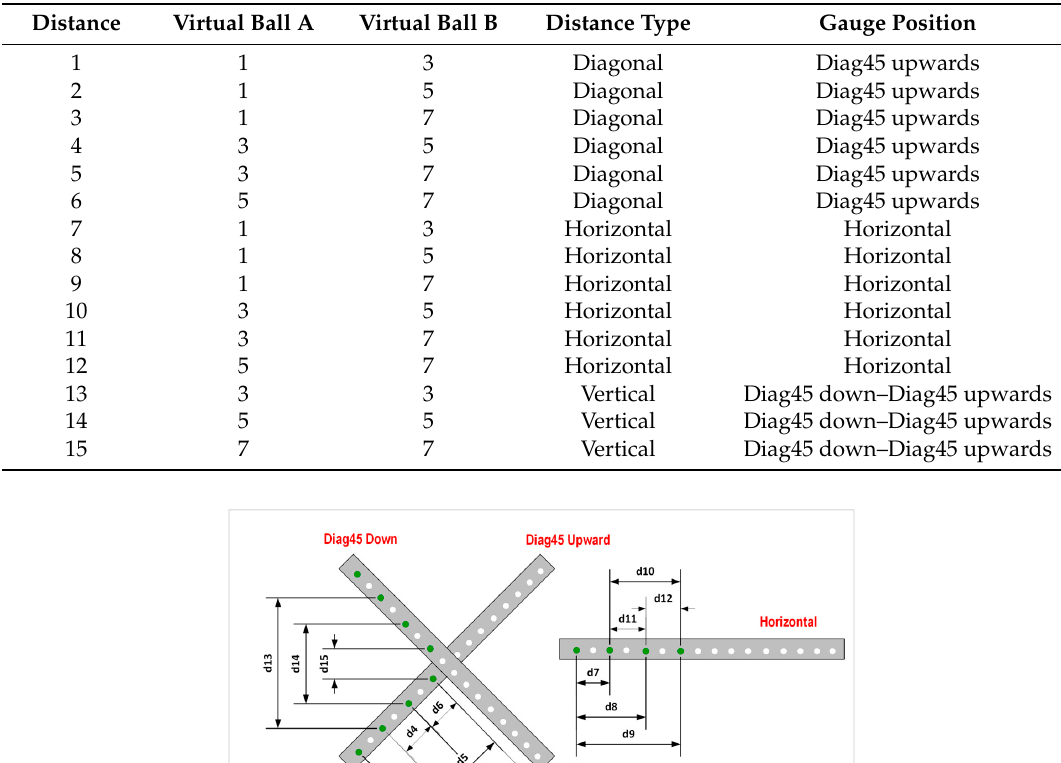
Table 5. Evaluation method 4: Virtual distances definition by mesh (1–6).